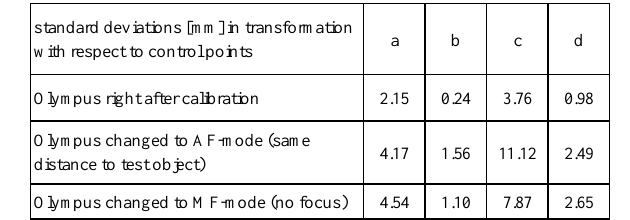
Figure 5. Variation in principal point for Olympus camera